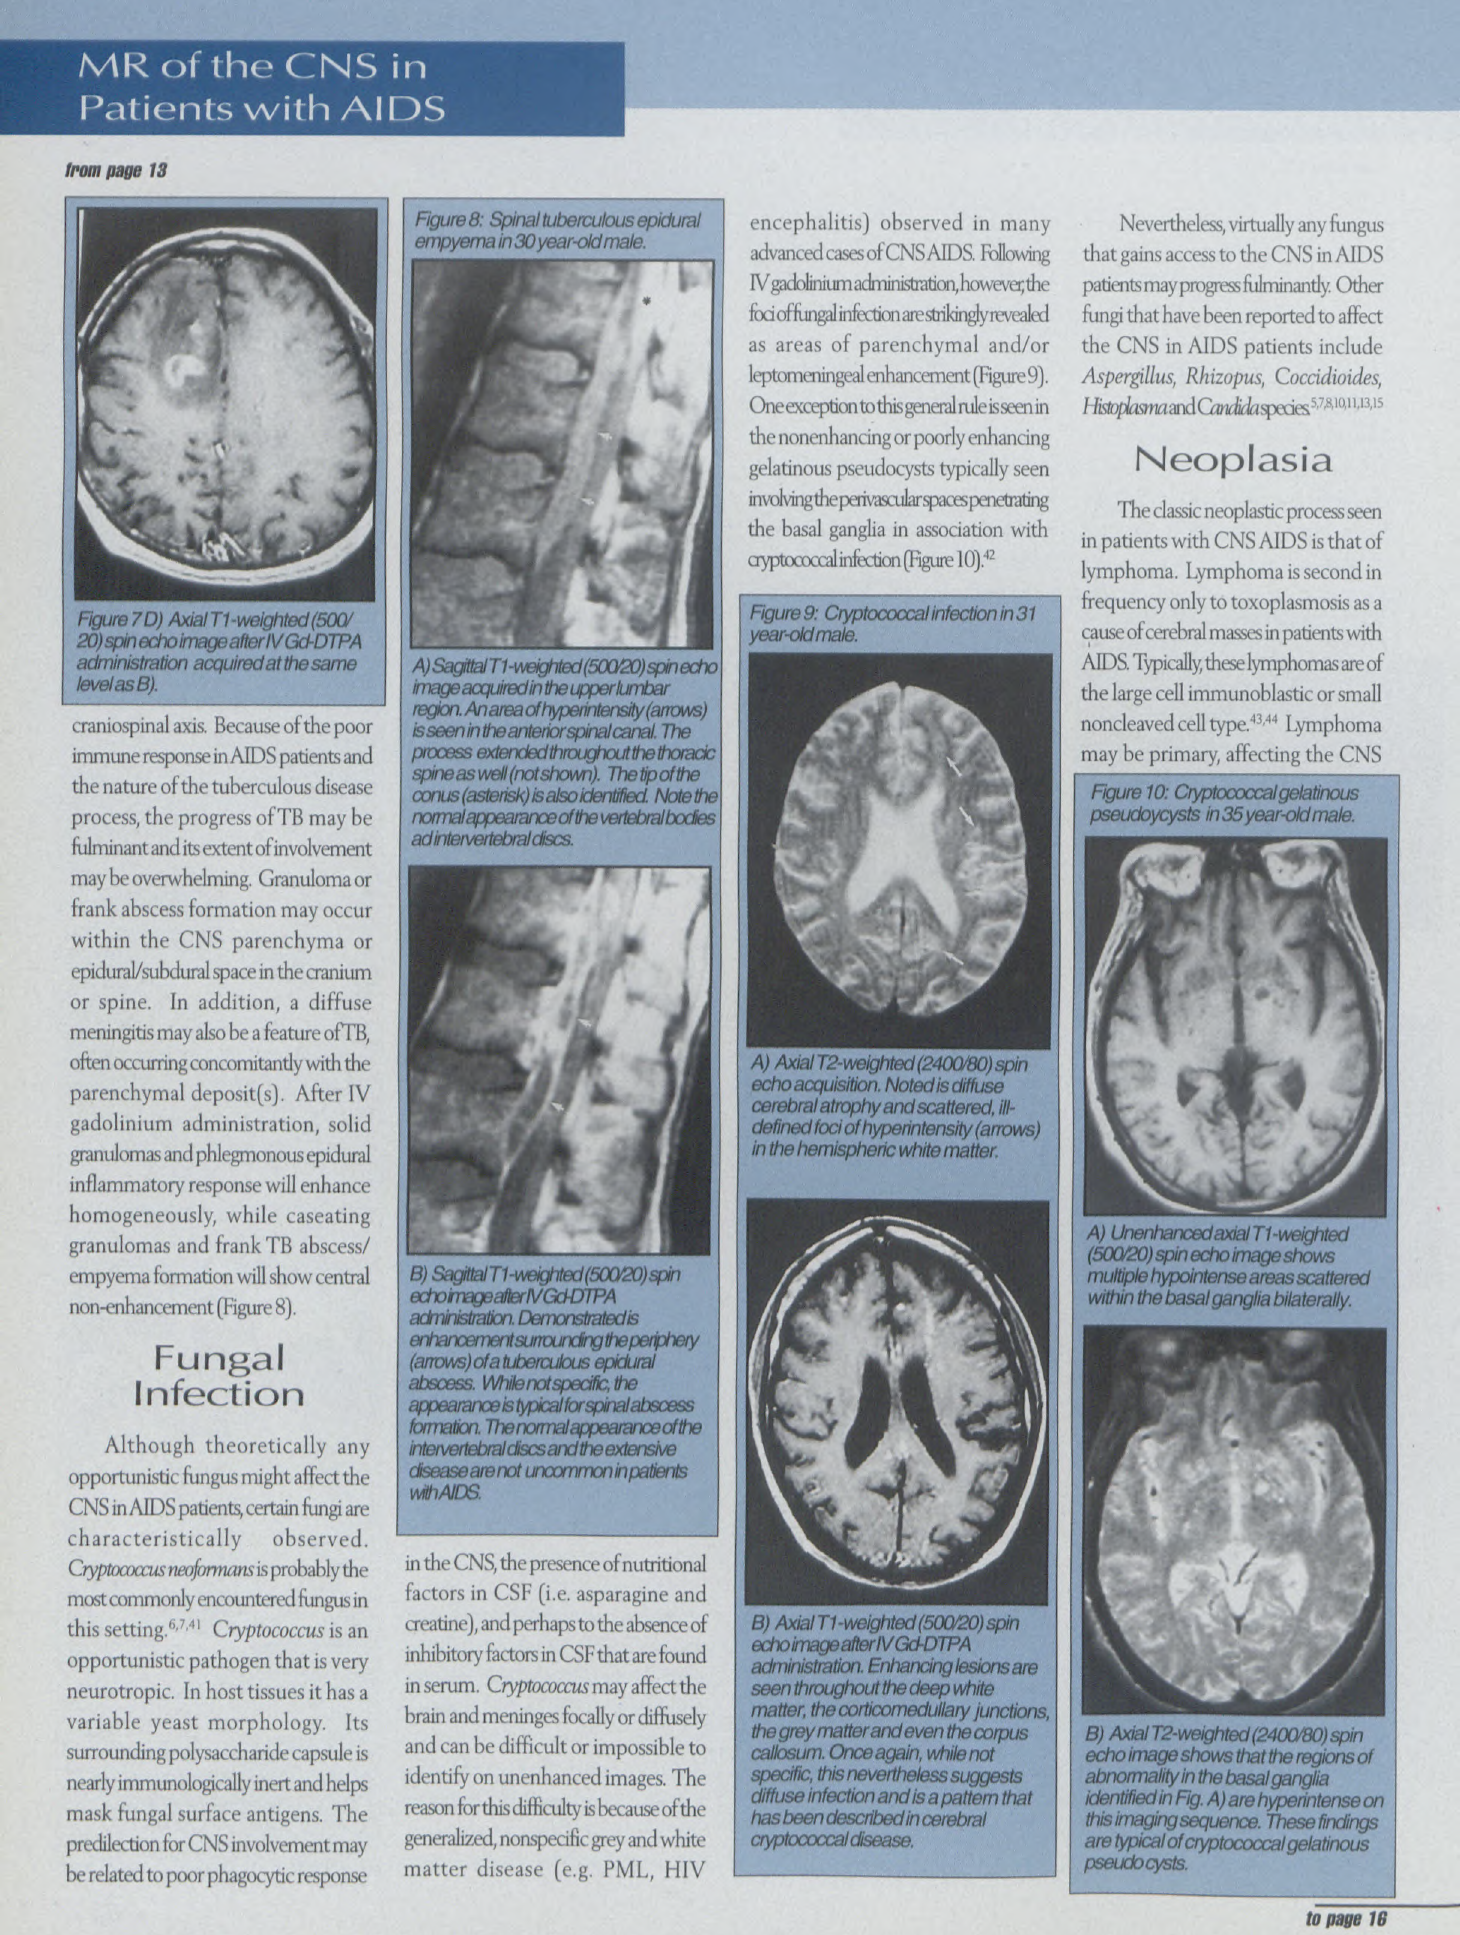
Figure 8: Spinal tuberculous epidural empyema in 30 year-old male.